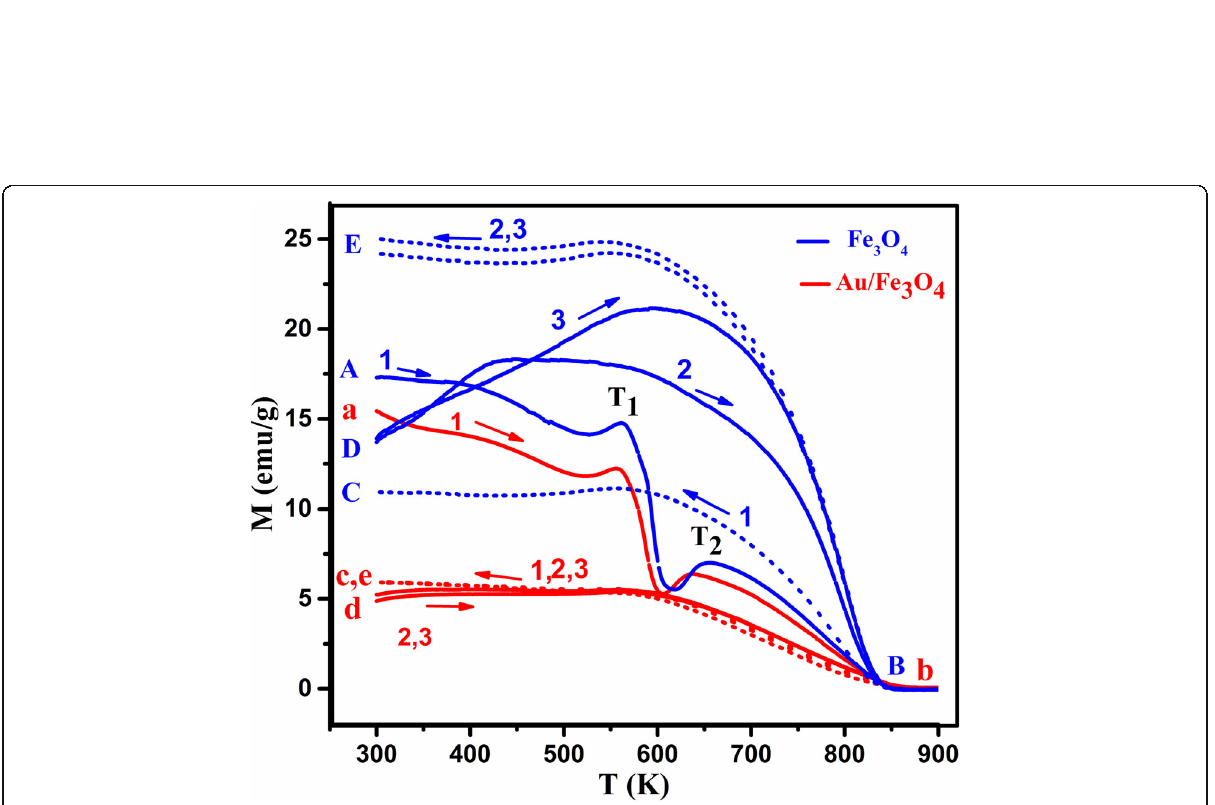
Fig. 10 Change of magnetization ( M ) with temperature of pristine Fe 3 O 4 (blue, capital letters) nanoparticles and Au/Fe 3 O 4 (red, small letters) for three indicated sequential heating – cooling cycles (magnetic field H = 200 Oe) (solid line, heating; dotted line,